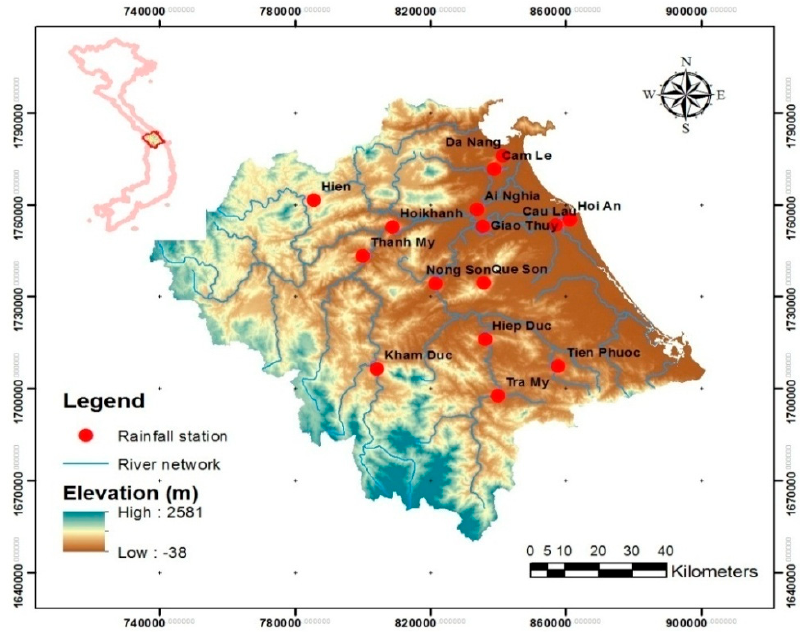
Figure 1. Network of hydro-meteorological stations at VG-TB basin.